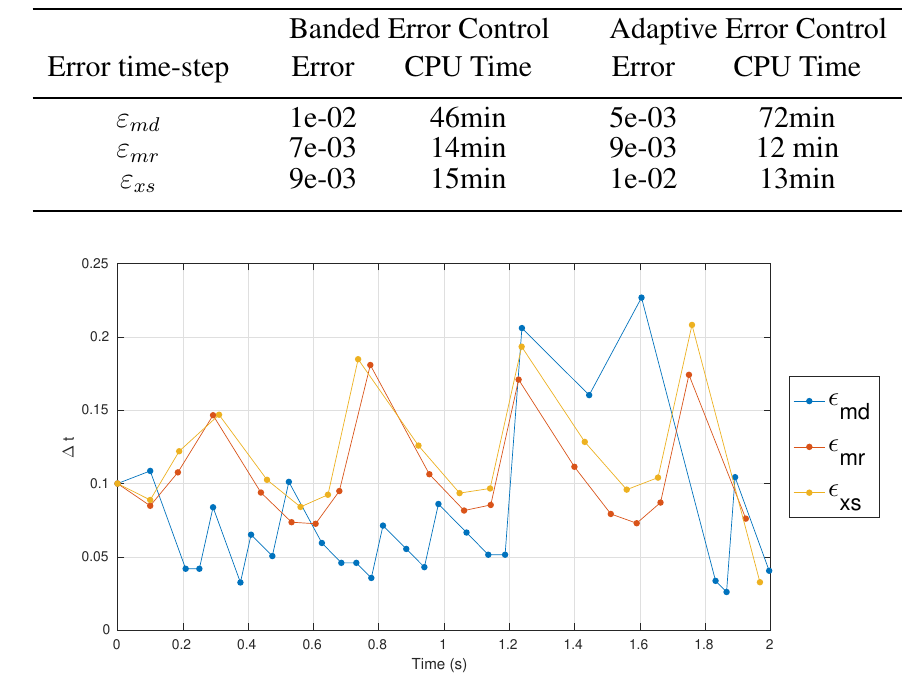
Figure 4: Evolution of the ∆ t along the time with the adaptive error